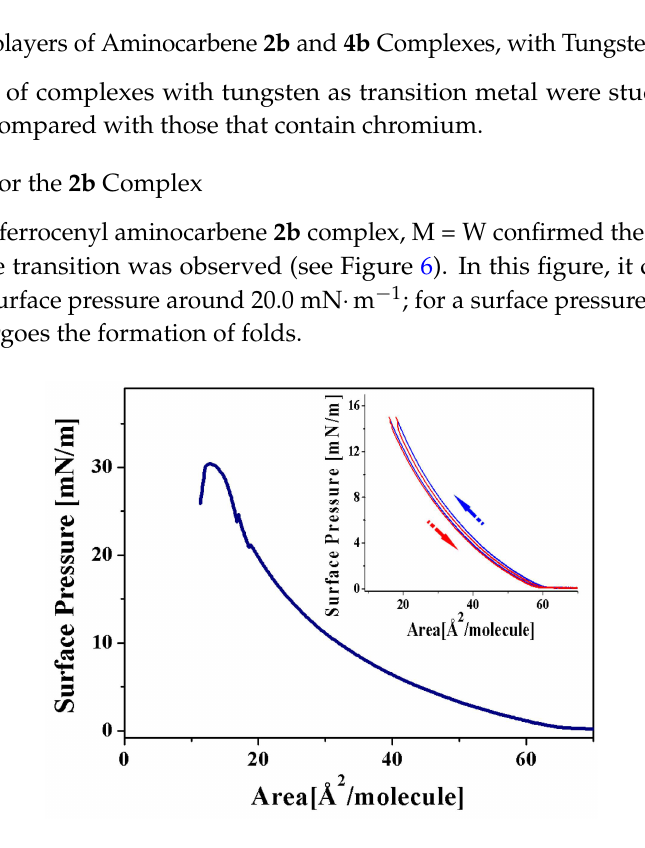
Figure 6. Surface pressure vs. molecular area isotherm of ferrocenyl aminocarbene complex 2b , M = W. Inset shows reversibility of two successive compression-expansion